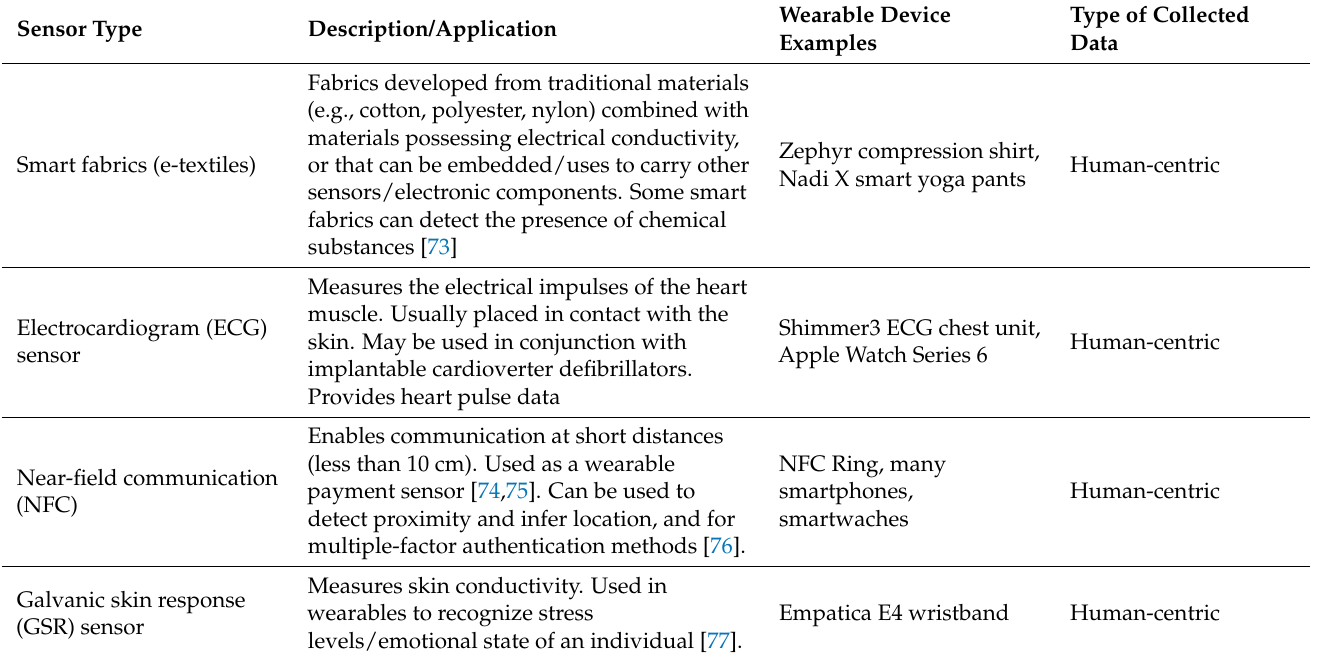
Table 3. Sensor technologies for wearable sensing